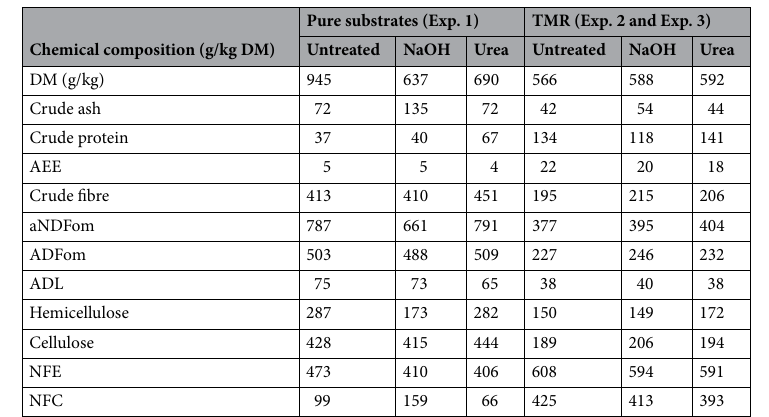
Table 1. Dry matter and crude nutrient concentrations of untreated barley straw, NaOH treated straw, and urea treated straw (Experiment 1), and in TMR including one of these straw treatments (Experiment 2 and Experiment 3). Practical TMR were composed of 33.5% maize silage, 21.6% rapeseed meal, 26.7% barley grains, and 18.2% of one of the straw treatments on DM basis. The straw treatments and conducted experiments are specified in the text. ADFom, acid detergent fibre expressed exclusive of residual ash; ADL, acid detergent lignin; AEE, acid ether extract; aNDFom, amylase-treated neutral detergent fibre expressed exclusive of residual ash; DM, dry matter; NFC, non-fibrous carbohydrates; NFE, nitrogen-free extract; TMR, total mixed